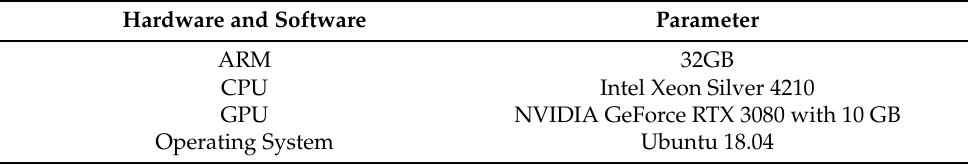
Table 1. Hardware and Software Platform Parameters.